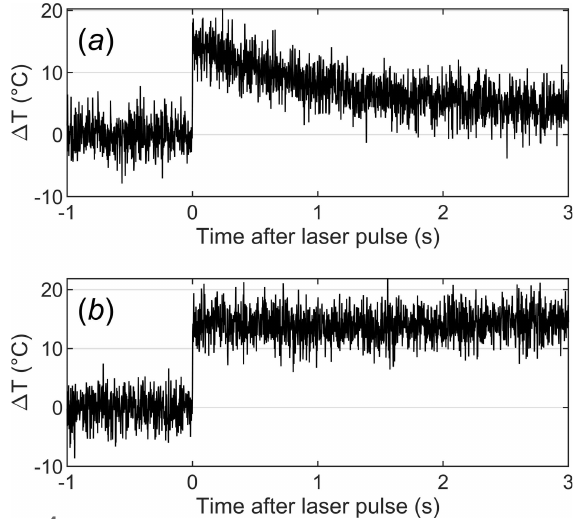
Figure 5 The spatial profile of the T-jump as seen by the X-ray beam. ( a ) Simulated T-jump and ( b ) observed T-jump over a section of the capillary. The grey box marks the approximate size of the X-ray spot and where it would be positioned during regular data acquisition. ( c ) Zoomed-in view of the grey box, showing the T-gradient of the probed